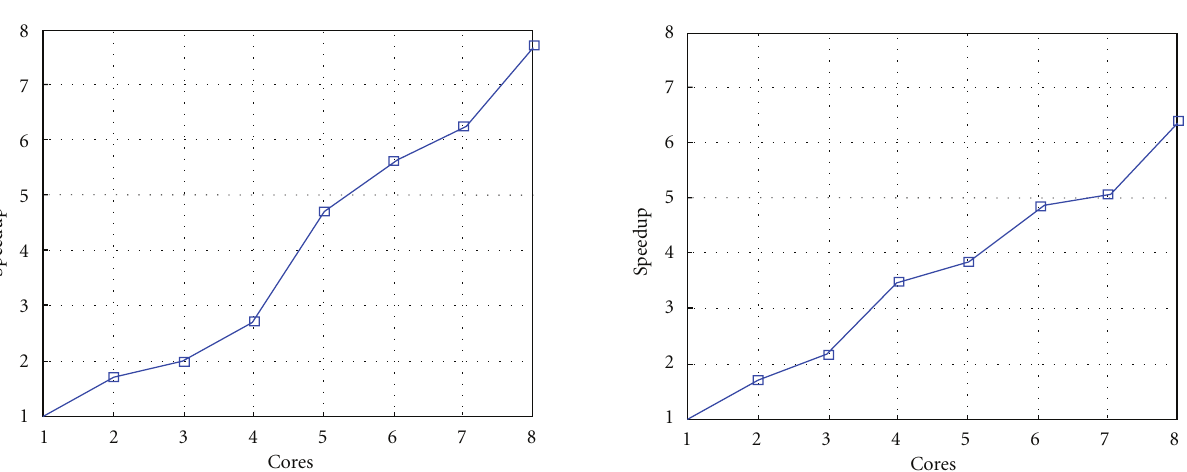
Figure 16: Test 1: Algorithm I: Speedup. Δ τ I = 0 . 4.